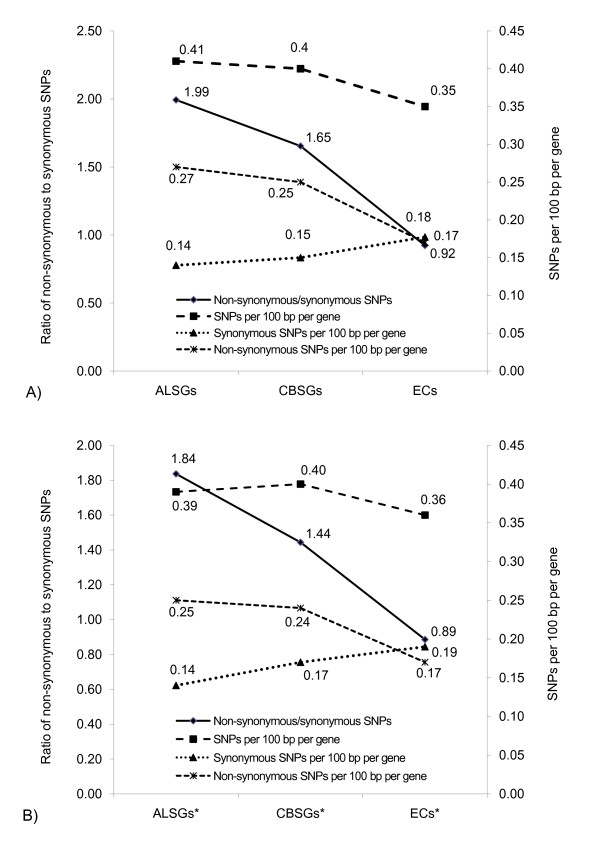
Ratio of non-synonymous to synonymous SNPs substitutions and the number of SNPs, non-synonymous SNPs, and synonymous SNPs per 100 bp per gene within coding regions of A) ALSGs, CBSGs, and ECs, and B) ALSGs, CBSGs, and ECs predicted to be targeted to the secretory pathway. Ratio of non-synonymous to synonymous substitutions SNPs is plotted in the solid line. Number of SNPs, non-synonymous SNPs, and synonymous SNPs per 100 bp per gene within coding regions is plotted in the dotted line. Lines are drawn between the 3 classses of genes to facilitate interpretation.